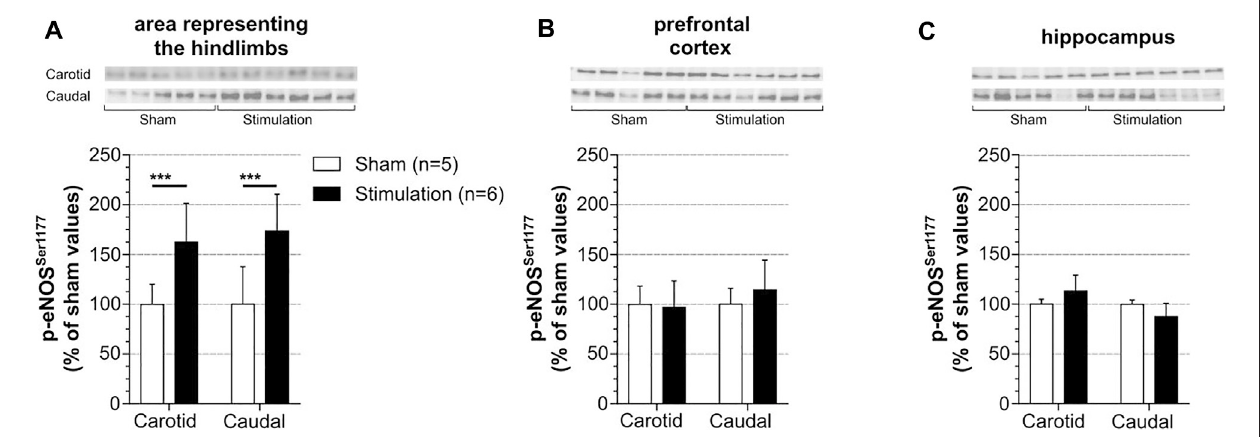
FIGURE 3 | Effect of induced contraction on p-eNOS CBF levels of p-eNOS Ser1177 were measured in the sensorimotor cortex (A) , prefrontal cortex (B) and hippocampus (C) 20 minaftercessationofa30 minelectricallyinducedcontractionofhindlimbs(5xMT)inratswithcatheterizationofthecommoncarotidartery(carotid series) or the caudal artery (caudal series). These rats are the same than those used to measure LDF CBF . Values are expressed as means ± SD, n = number of rats. *** signi fi cantly different from sham rat values after t -test at p <